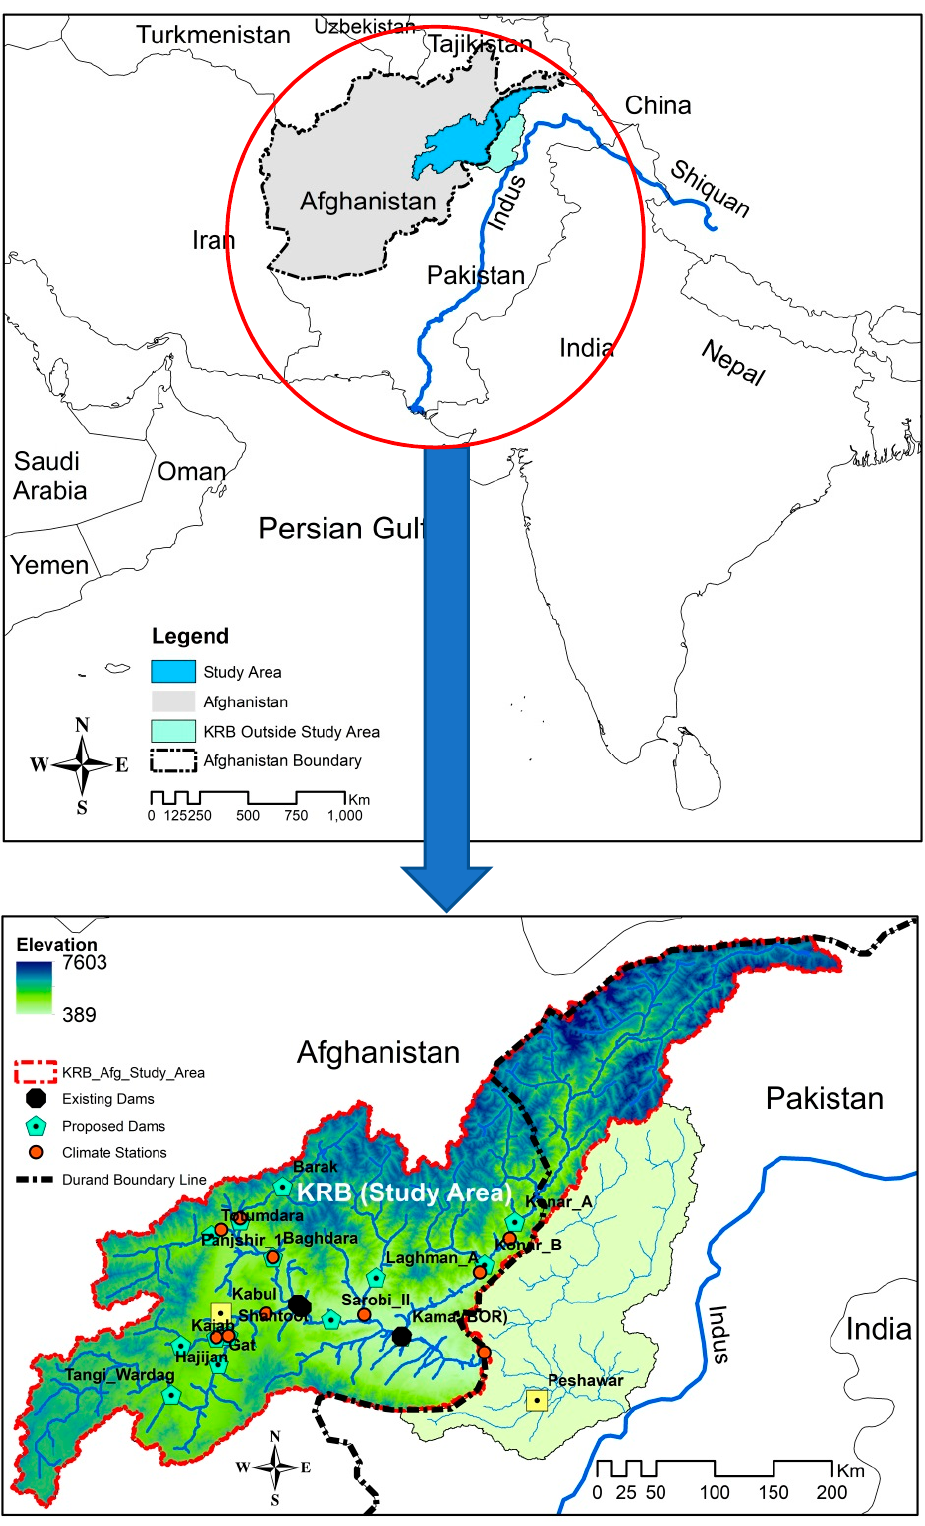
Figure 1. Location of the Kabul River Basin and the study area (circled in red). Table 1. Existing and proposed dams in the KRB (Afghanistan) (Source: WB, 2010; Vol 1, Chapter 4, Toosab and RCUWM 2006 mission estimates).